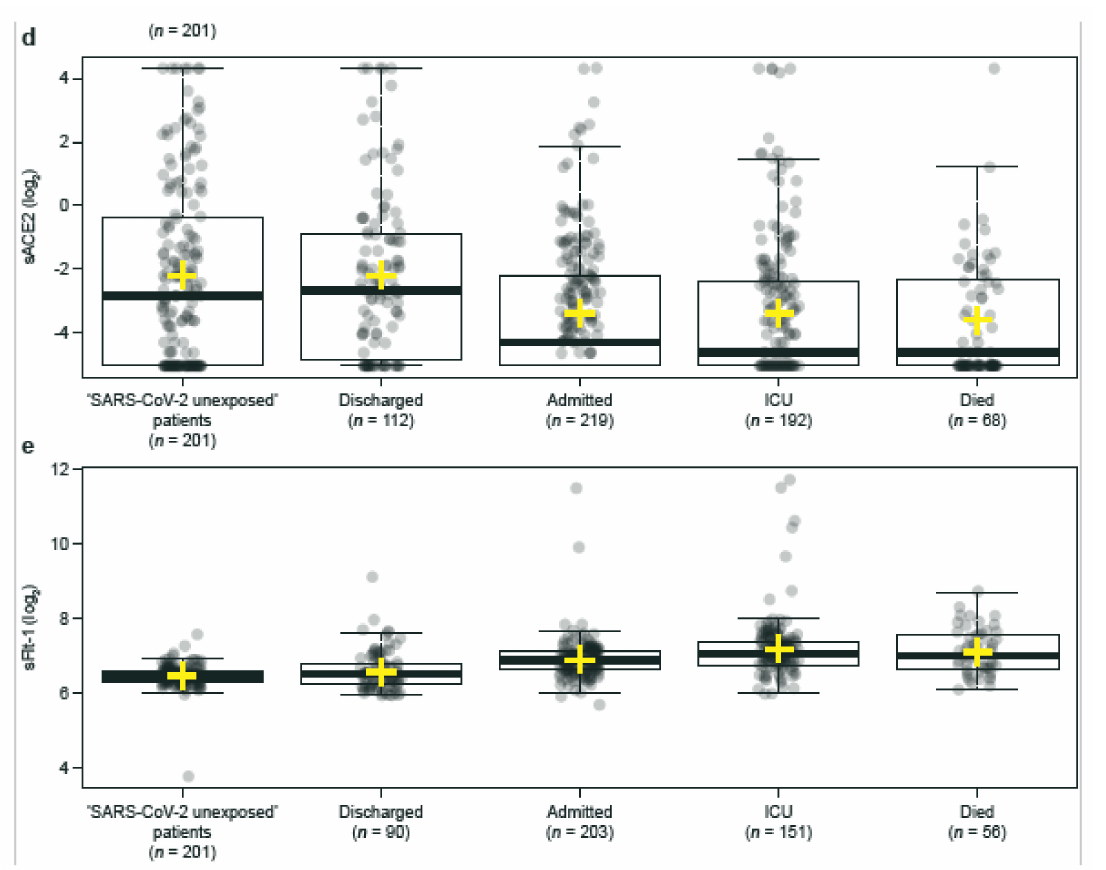
Figure 1. Levels of ( a ) CRP, ( b ) GDF-15, ( c ) IL-6, ( d ) sACE2, and ( e ) sFlt-1 by disease severity in patients with SARS-CoV-2 who were admitted to hospital (Groups 2–4) and patients with SARS-CoV-2 who were discharged (Group 1). Thick black line = median; yellow cross = mean; upper/lower limits and whiskers = interquartile range and maximum/minimum values excluding